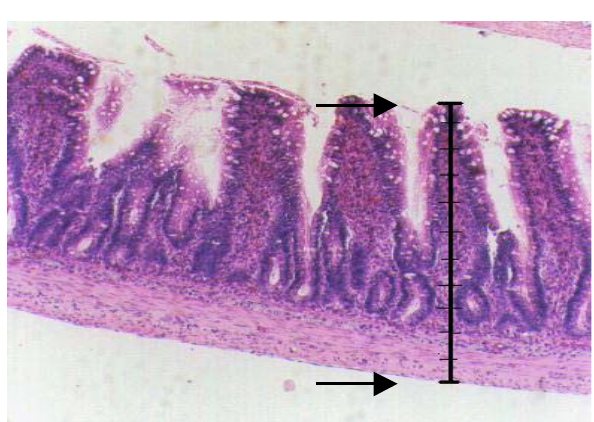
FIGURA 1 - Representação esquemática da mensuração de uma vilosidade da camada serosa até o epitélio (fotomicrografia com objetiva de 10